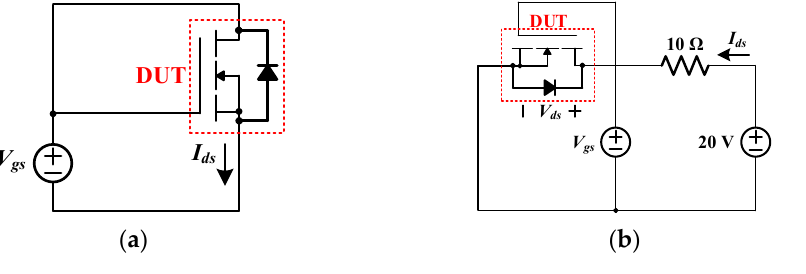
Figure 5. Measurement circuits ( a ) V th ( b ) R on .